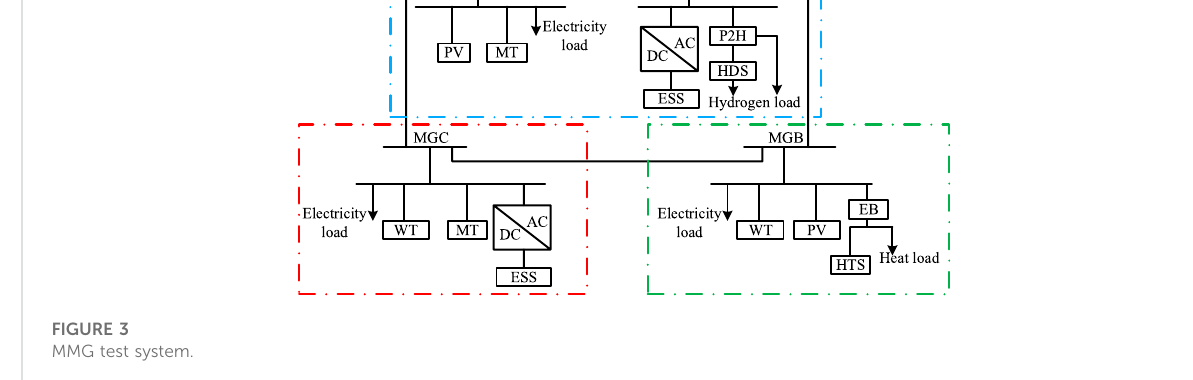
FIGURE 3 MMG test system.